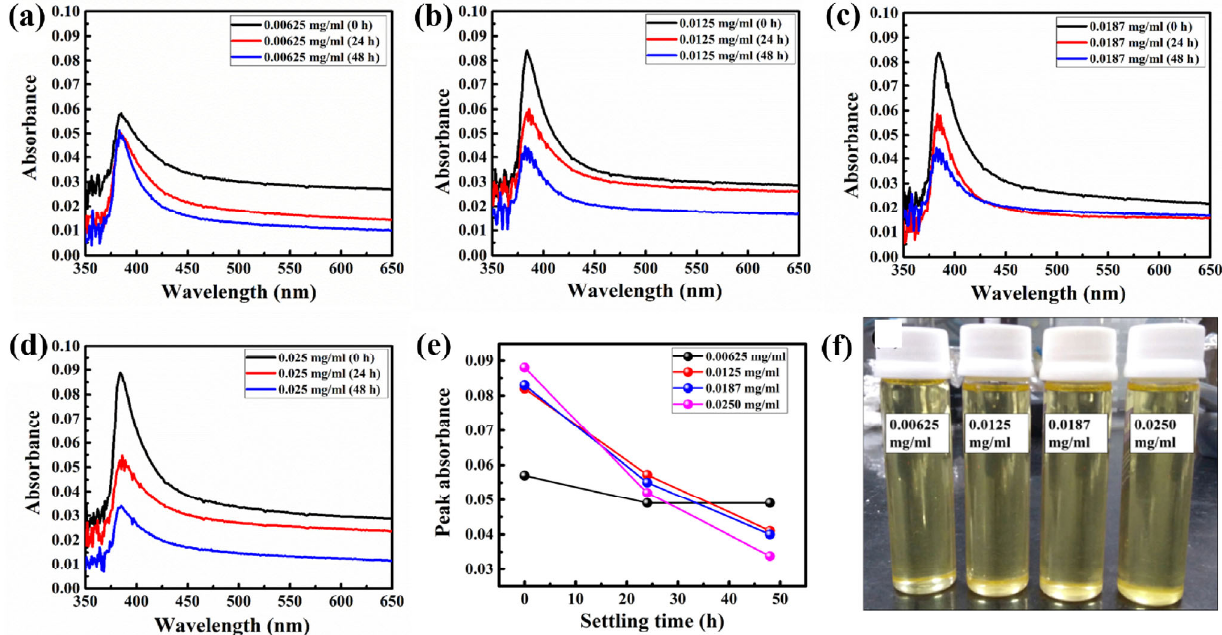
Fig. 4 UV-visible absorption spectra of nano-oil at different concentration: (a) 0.00625 mg/ml, (b) 0.0125 mg/ml, (c) 0.0187 mg/ml, and (d) 0.025 mg/ml. (e) Relative absorbance plot for all concentrations and (f) digital photograph of the nano-oil after 48